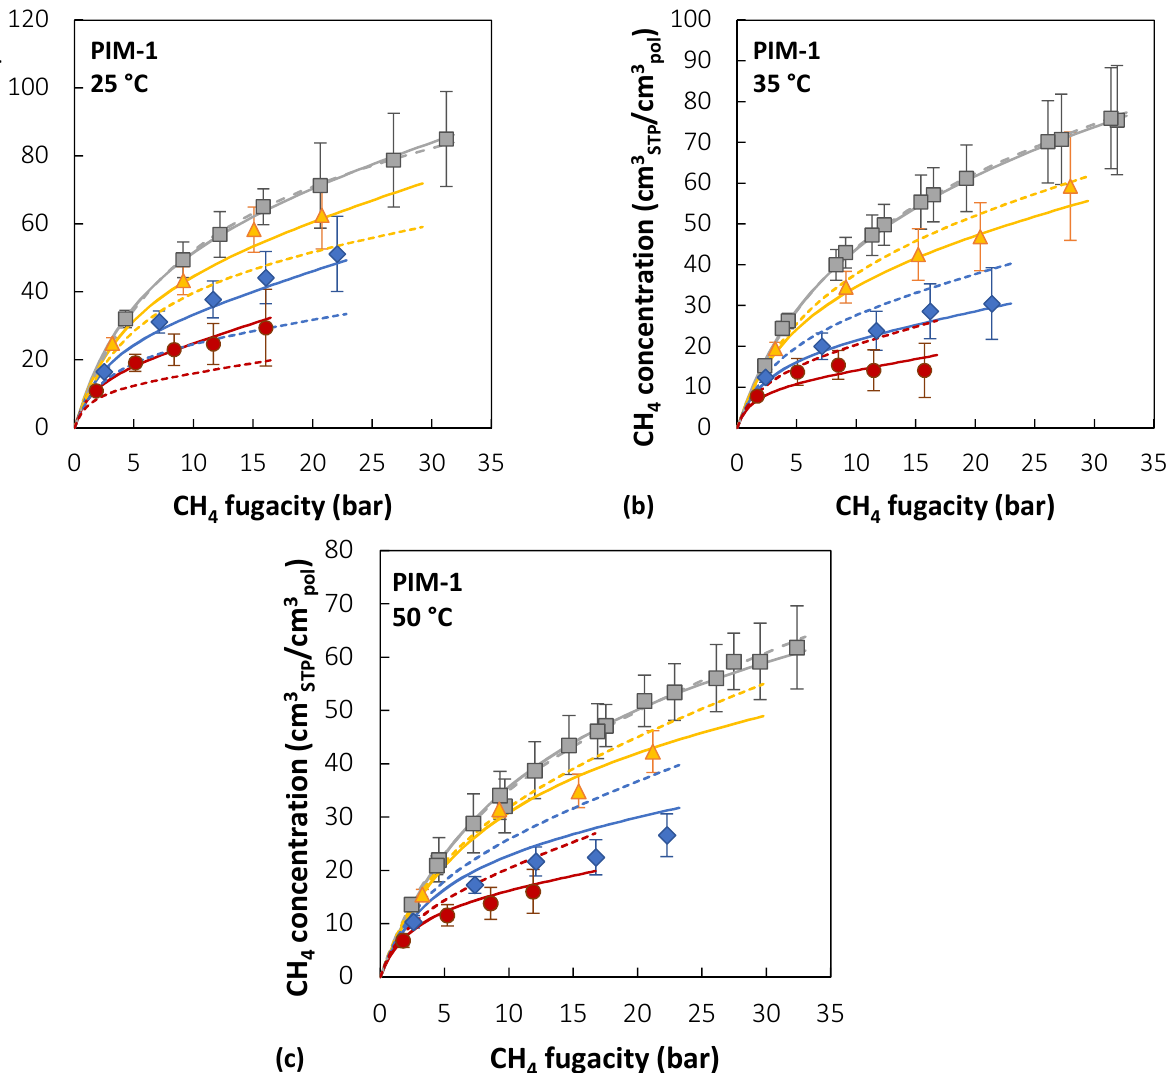
Figure 9. Dual-Mode Sorption model mixed-gas predictions of CH 4 sorption in PIM-1 at ( a ) 25 °C, ( b ) 35 °C, and ( c ) 50 °C obtained with the two parameter sets reported in Table 3: solid lines correspond to Set 1; dashed lines correspond to Set 2 [191]; grey squares, pure gas; yellow triangles, ~ 10% CO 2 mixture; blue diamonds, ~ 30% CO 2 mixture; red circles, ~ 50% CO 2 mixture [39,40]).